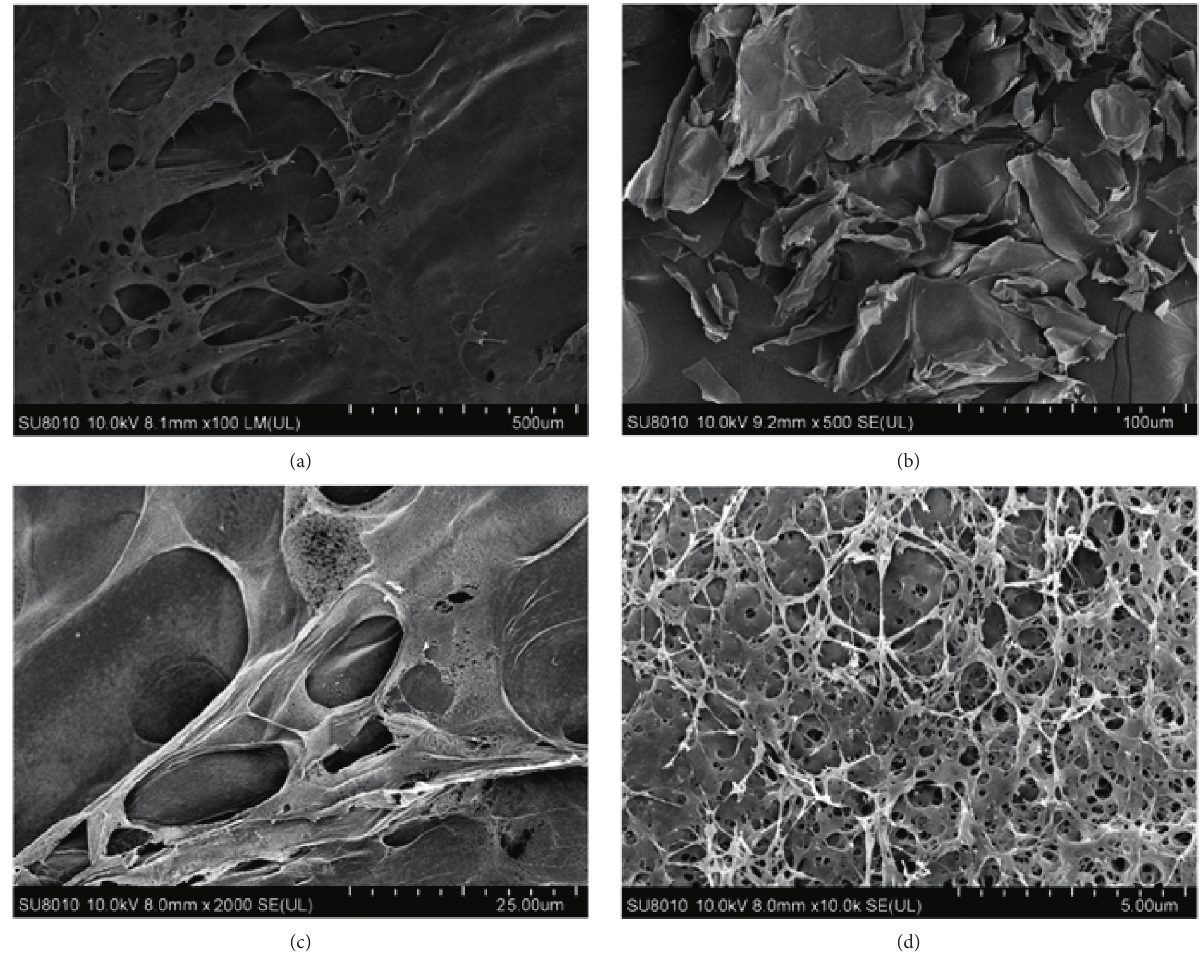
Figure 4: Scanning electron microscope image of TSP obtained from magnification 100x (a), 500x (b), 2,000x (c), and 10,000x